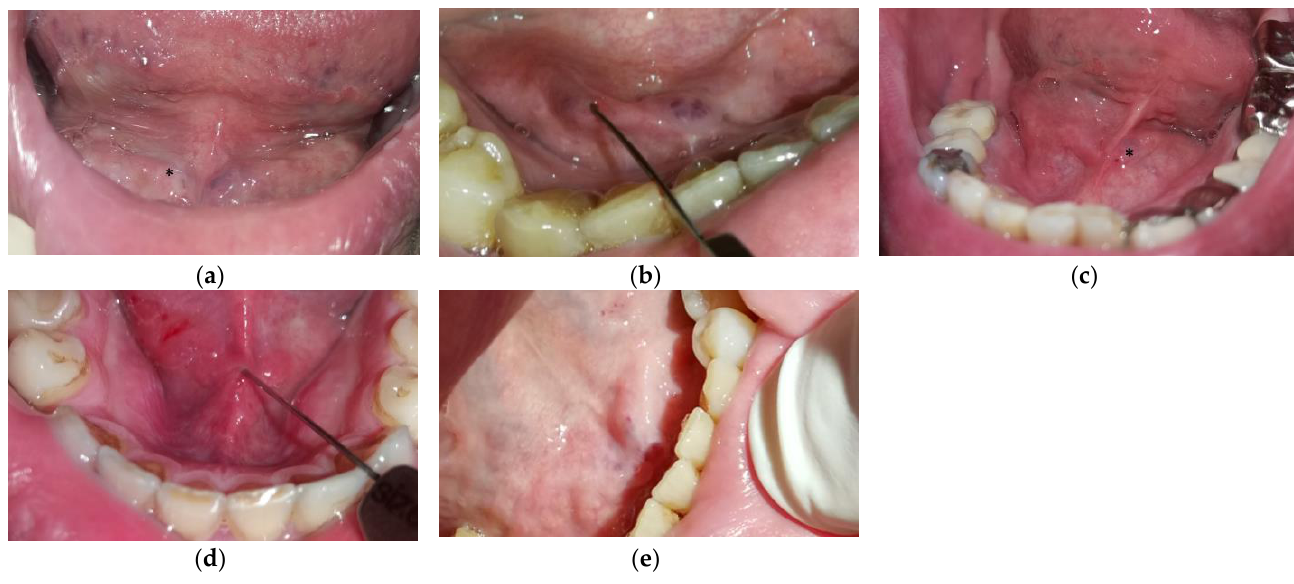
Figure 4. Submandibular duct papillae. ( a ) displays an estuary-like papilla (type A) on the patient ’ s right side before inserting the dilatation probes (asterisk *). The following two figures demonstrate normal papilla (type B) in two patients. In ( b ), the dilatator is inserted into the papilla, while the patient ’ s left papilla (asterisk *) is already dilatated in ( c ). ( d ) displays a difficult papilla (type C) with the dilatator inserted. In this patient, the narrow mandibula and mandibular torus hindered the